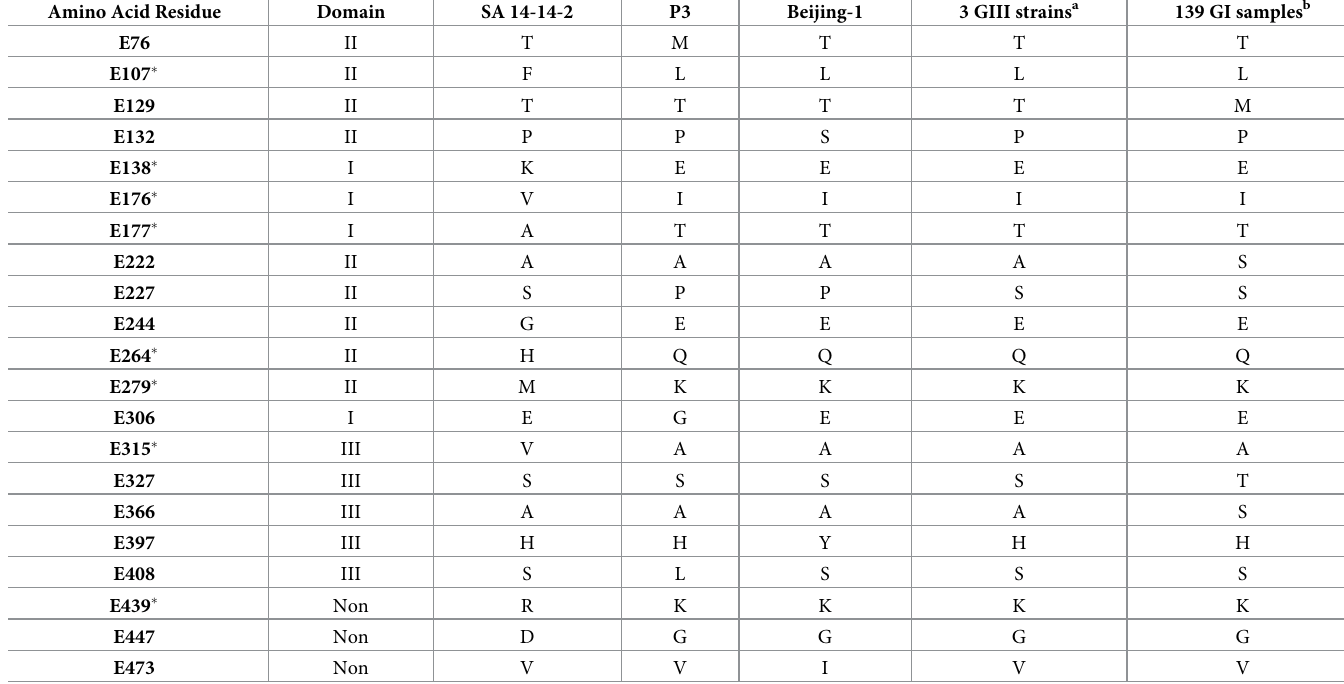
Note � indicates the eight key amino acid residues related to neuroinvasiveness and neurovirulence attenuation in E gene. a indicates the 3 isolated GIII JEV strains in Zhejiang Province in 1982–1983. b indicates the 139 JEV-positive sequencing samples (GI) in Zhejiang Province in